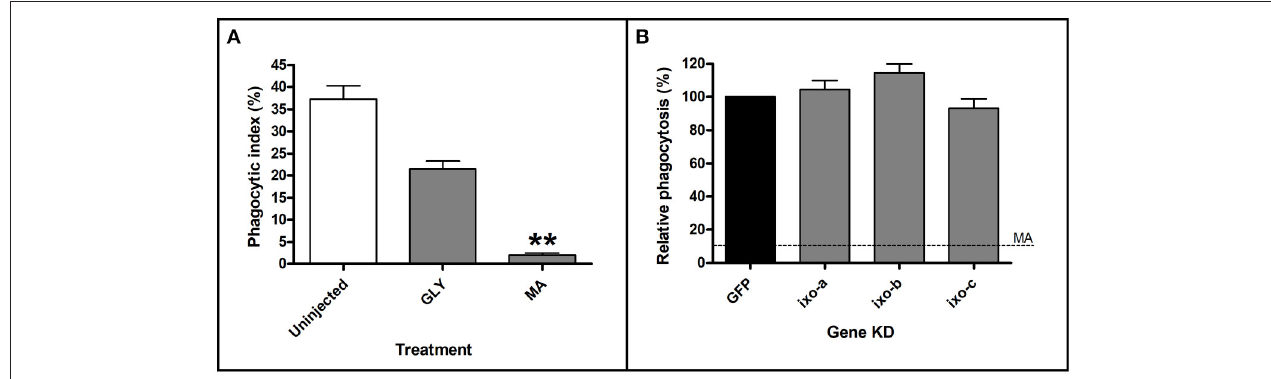
FIGURE 7 | Pre-treatment of hemolymph with methylamine (MA), but not ixoderin KDs affects phagocytosis of Borrelia . Tick hemocytes after MA pre-treatment (A) or ixoderin KD (B) were incubated in vitro with B. afzelii CB43. At least five independent slides with hemocytes were analyzed for each of three biological replicates. The phagocytic index in (A) was determined as the ratio of phagocytic vs. non-phagocytic hemocytes, and the level of phagocytosis in (B) was set as 100% in the dsGFP control. (Uninjected) untreated hemolymph, (GLY) glycine pre-treatment (control), (MA) MA pre-treatment. Dashed line in (B) indicates phagocytosis level after MA treatment. Two asterisks indicate p -value < 0.001.